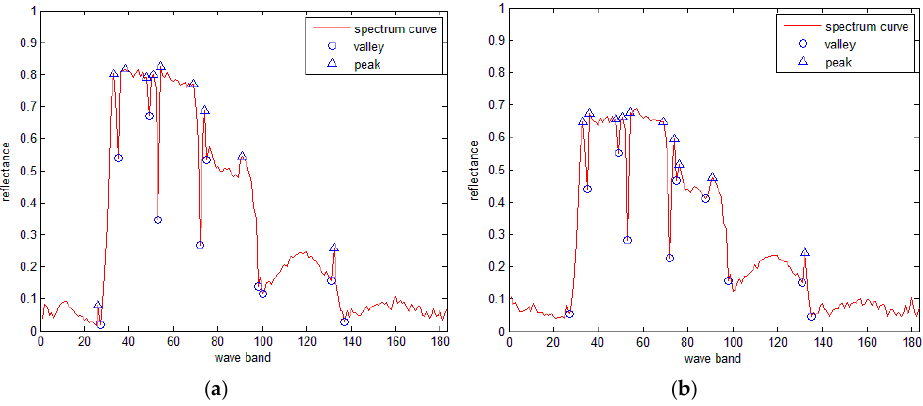
Figure 2. The SRAI features extracted from the spectral curves of a ( a ) tree and ( b ) wheat.